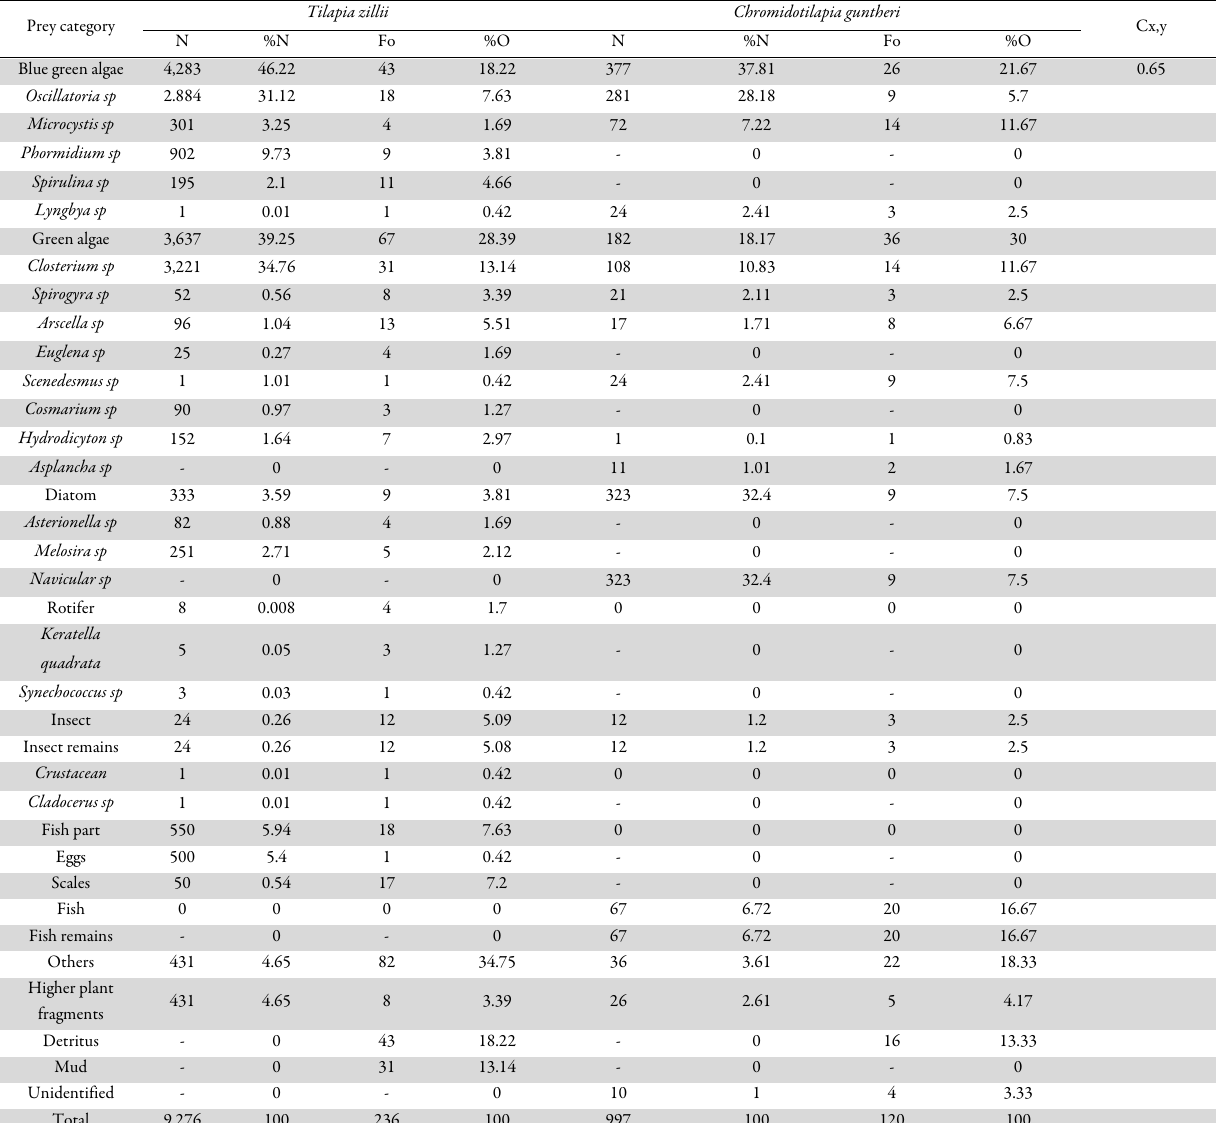
Table 4. Prey items observed (N), percentage of prey items observed, (%N), frequency of occurrence (Fo), percentage occurrence (%O), and diet overlap indexes of Tilapia zillii and Chromidotilapia guntheri from Igun reservoir Prey category Blue green